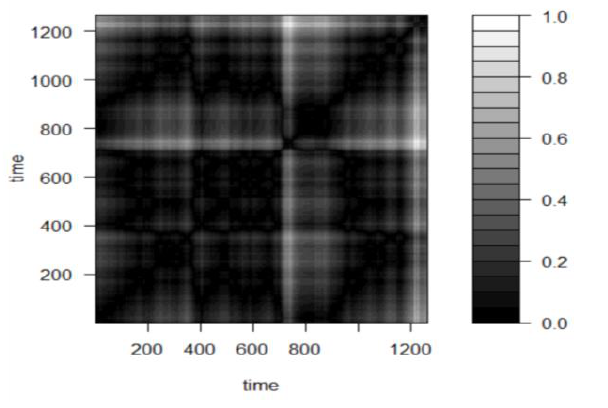
Figure 4: Recurrence plot - Crude Brent oil; Source: Author